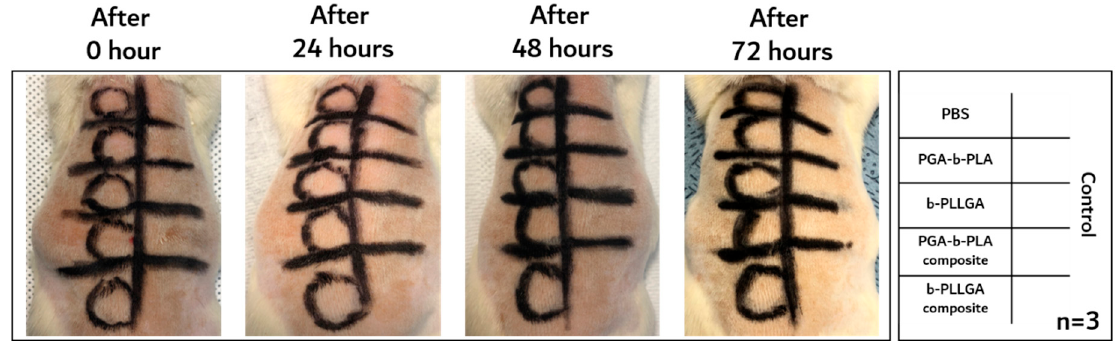
Figure 6. Skin sensitization analysis of the extracted solution injection obtained 24, 48, and 72 h after injection ( n = 3).